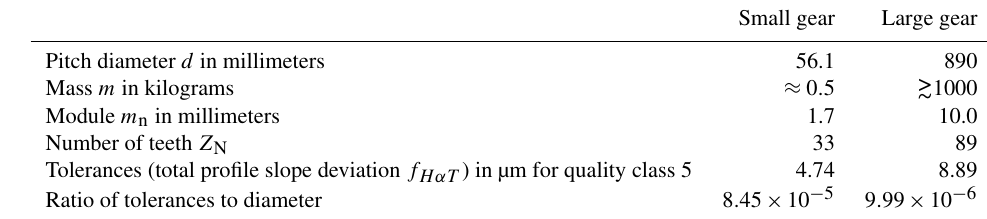
Table 1. Parameters of a small gear compared to the parameters of a large gear according to ISO 1328-1